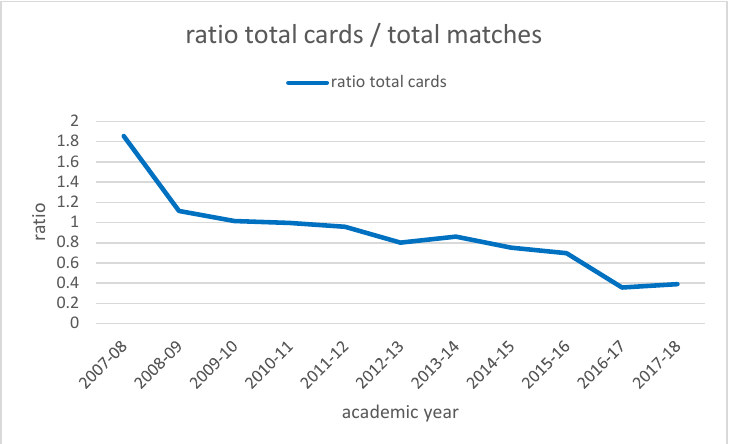
Figure 3. evolution of ratio of total cards through the academic years. Source: Own elaboration.